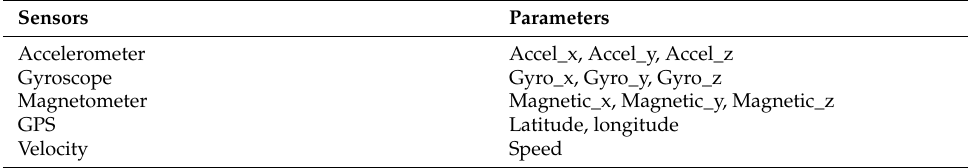
Table 2. Parameters collected using smartphones